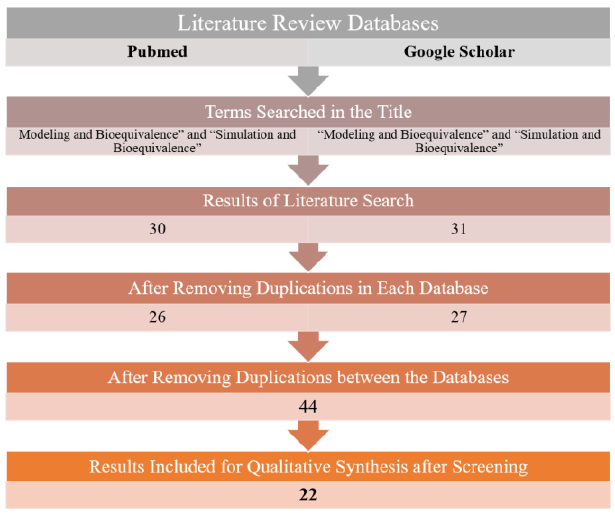
Figure 2. Results from literature review for the terms “modeling and bioequivalence” and “simulation and bioequivalence” using Pubmed and Google Scholar databases in accordance with PRISMA guidelines. Table 1. Frequency of in vitro and in silico use of results to support of bioequivalency tests. In Vitro / In Silico Number of Times Used in the Reviewed